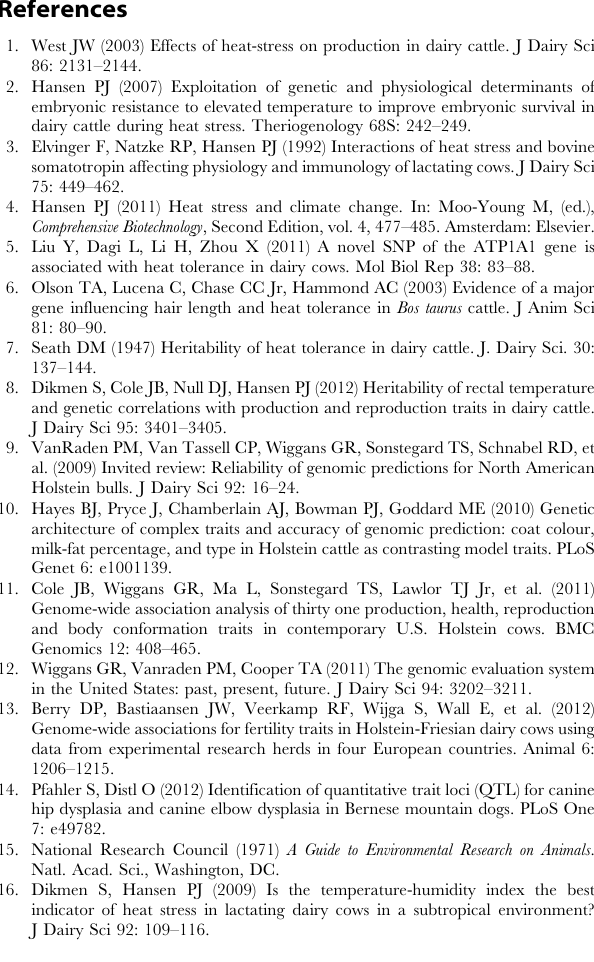
Figure S1 Proportion of SNP variance explained by individual SNP effects for rectal temperature from a single-step GBLUP analysis. Figure S2 Proportion of SNP variance explained by 2-SNP moving windows for rectal temperature from a single-step GBLUP analysis. Figure S3 Proportion of SNP variance explained by 4-SNP moving windows for rectal temperature from a single-step GBLUP analysis. (PNG) Figure S4 Proportion of SNP variance explained by 10-SNP moving windows for rectal temperature from a single-step GBLUP analysis. (PNG) Table S1 The 20 loci with the largest single-SNP proportion of SNP variance explained for rectal temperature. Table S2 The 20 loci with the largest proportion of SNP variance explained for rectal temperature using 2-SNP sliding windows.